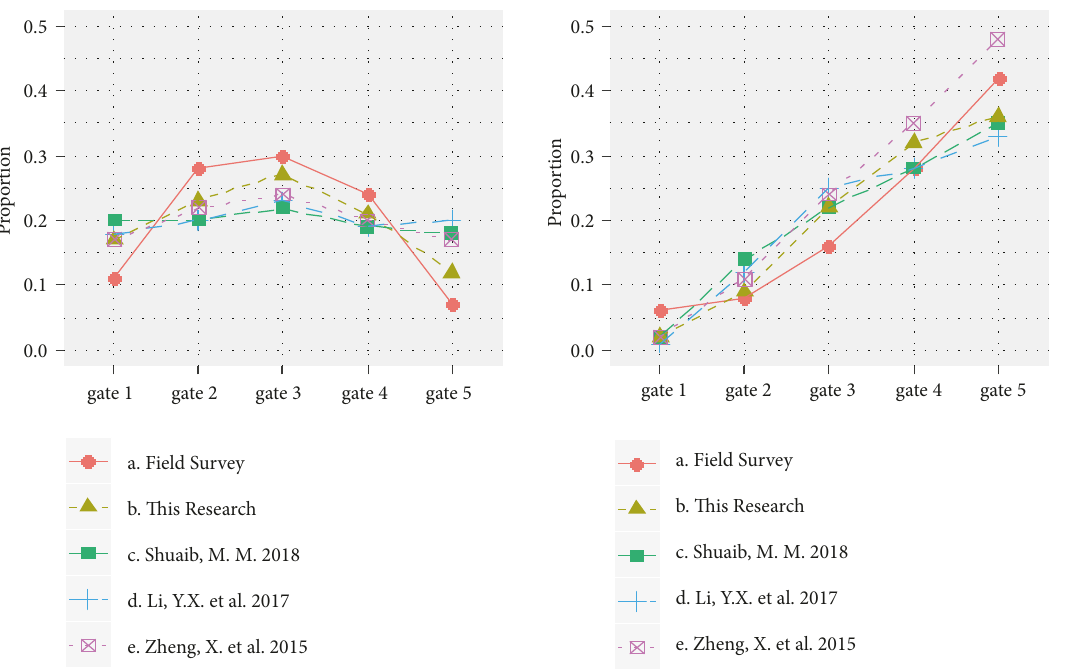
Figure 14: The survey data and simulation results under symmetric layout (left) and asymmetric layout (right).